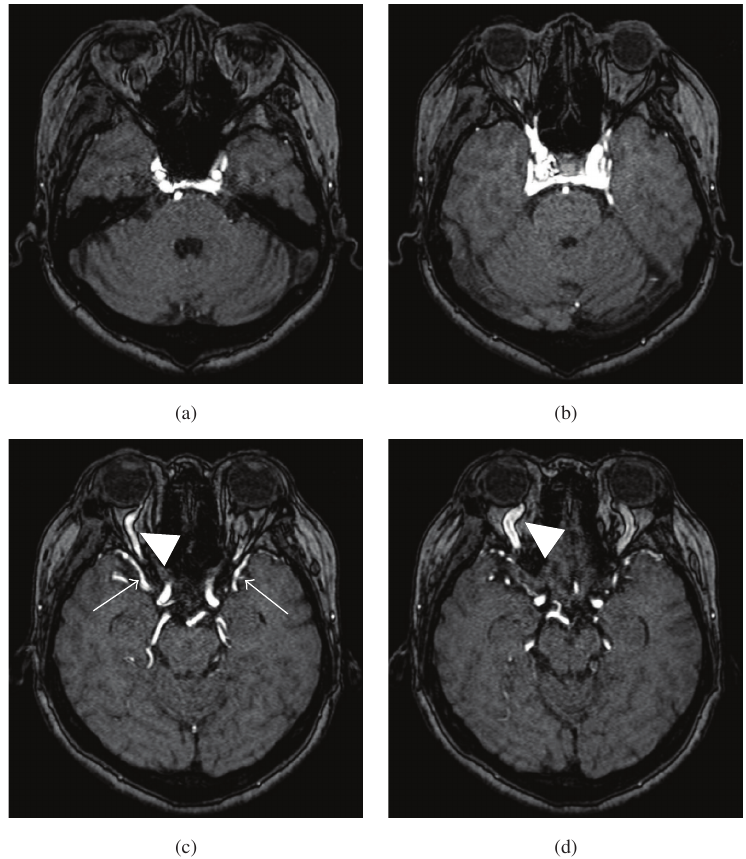
FIGURE 2: The source image of magnetic resonance angiogram (MRA) revealed increased transsellar collaterals (a, b), enlarged both inferior cerebral veins (C; arrow) and right side predominant elongated bilateral tortuous superior ophthalmic veins (c, d; arrow